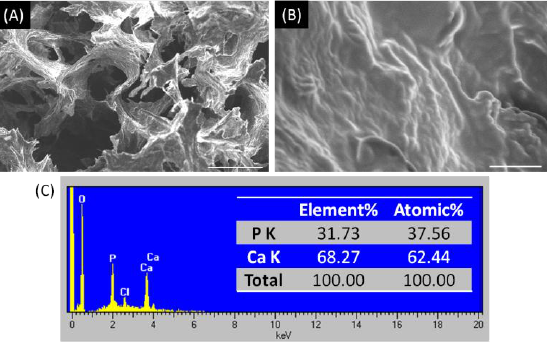
Figure 5. SEM images of nHap/Col composite scaffolds. Scale bar: ( A ) 100 μm; ( B ) 5 μm; ( C ) EDX spectrum of the selected area of nHap/Col nanocomposite scaffold; inset table presents the atomic ratio, percentage of the components in the nHap/Col composite.